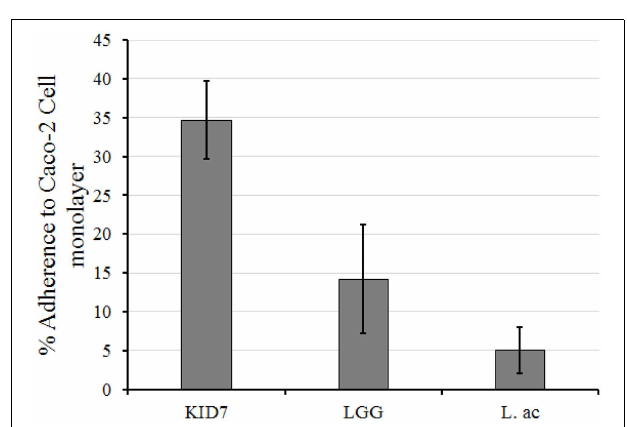
treatment. Green color indicates viable bacteria; red color indicates damaged or dead bacteria. (B) Viable count of KID7 after each stages of simulated oro-gastrointestinal transit. The viable count of KID7 was determined by plating the cells from each stage on MRS agar and incubation at 37 ◦ C for 48h. Error bar represents standard error of mean of three independent experiments. *** Significantly different from initial count at P < 0 . 005 .